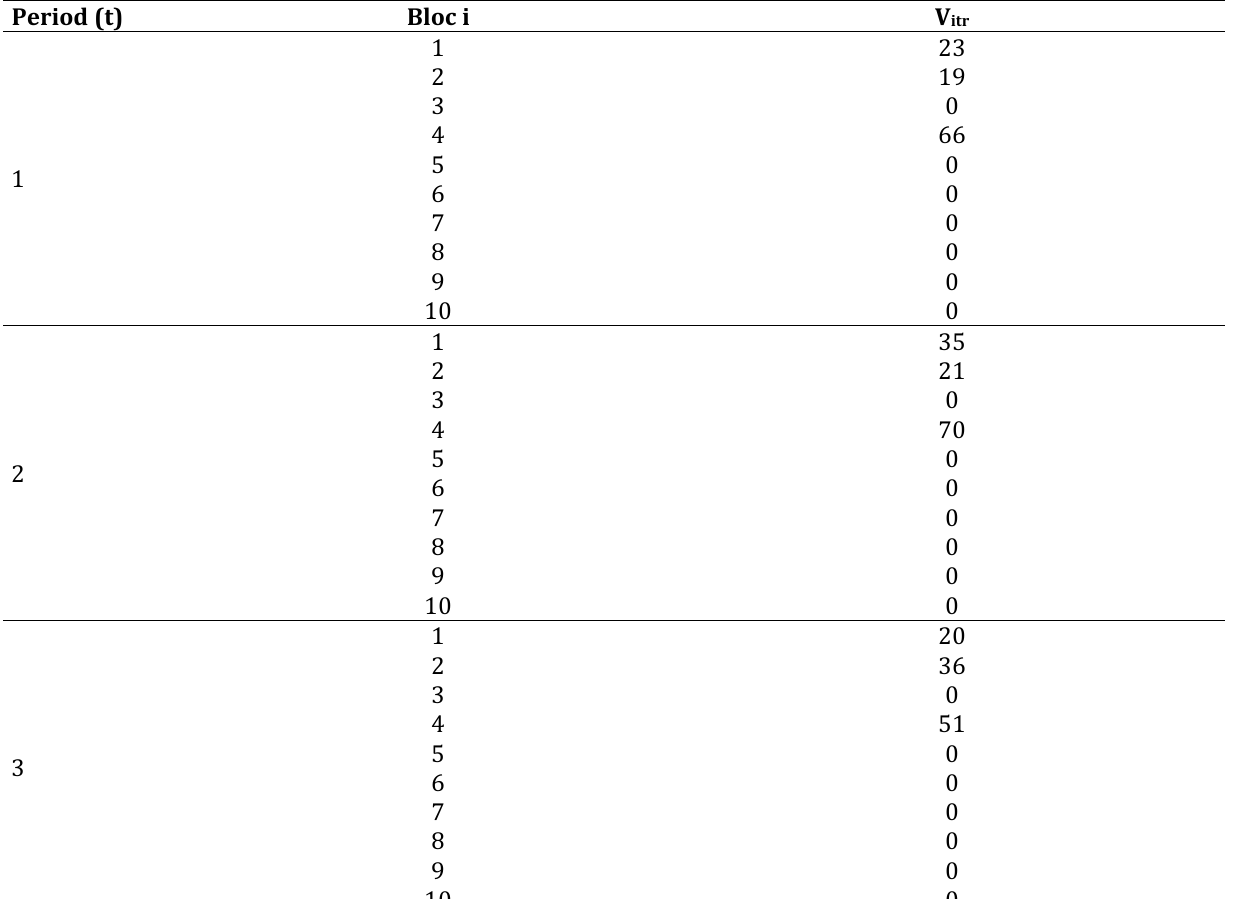
Table 7: Number of C1 and C2 containers in 10 blocks at the end of the period (t) Period (t) Bloc i